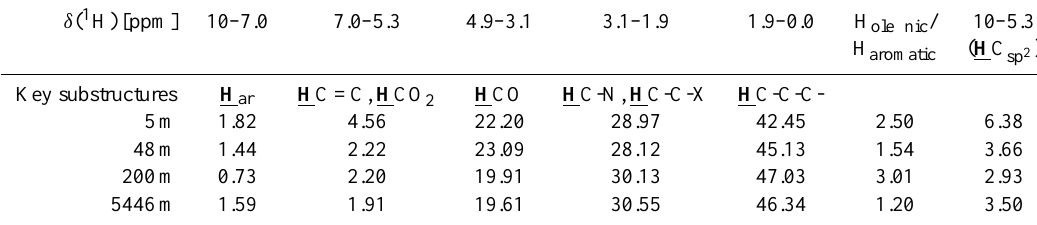
Table 2. 1 HNMR section integrals (percent of non-exchangeable protons) and key substructures from four marine SPE-DOM